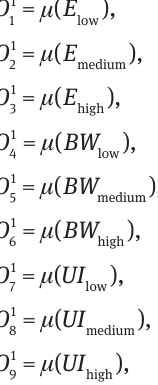
Rules layer: every node in this layer is a fixed node. The inputs to each node are connected by fuzzy AND (intersection operator) as shown in IF-THEN rules in Table 6. Each node output is the product of its incoming